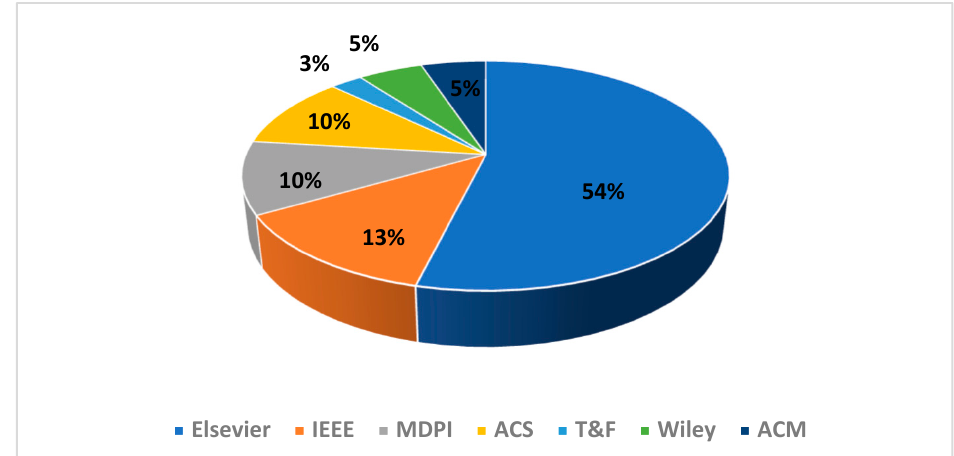
Figure 6. Distribution of the excluded articles according to the publisher.